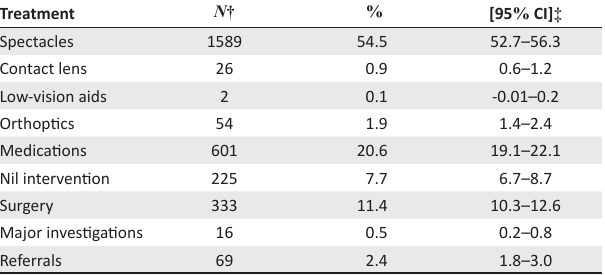
FIGURE 3: Percentage of ocular disorders diagnosed during the consultation. TABLE 3: Treatment options provided for the patients who visited public eye care clinics.